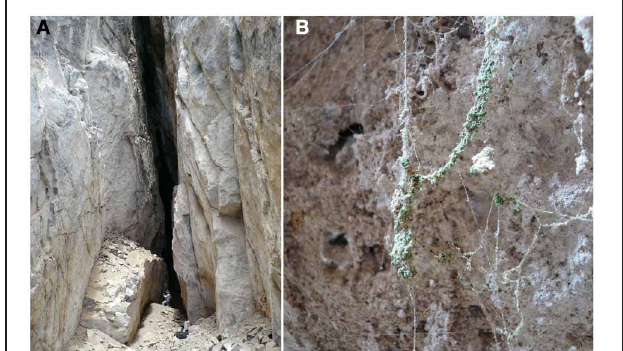
FIGURE 3 | The Dunaliella cave. (A) Image showing the entrance of the cave, with a person standing in front of the wall where colonized spider web can be found. (B) A spider web heavily colonized by Dunaliella .